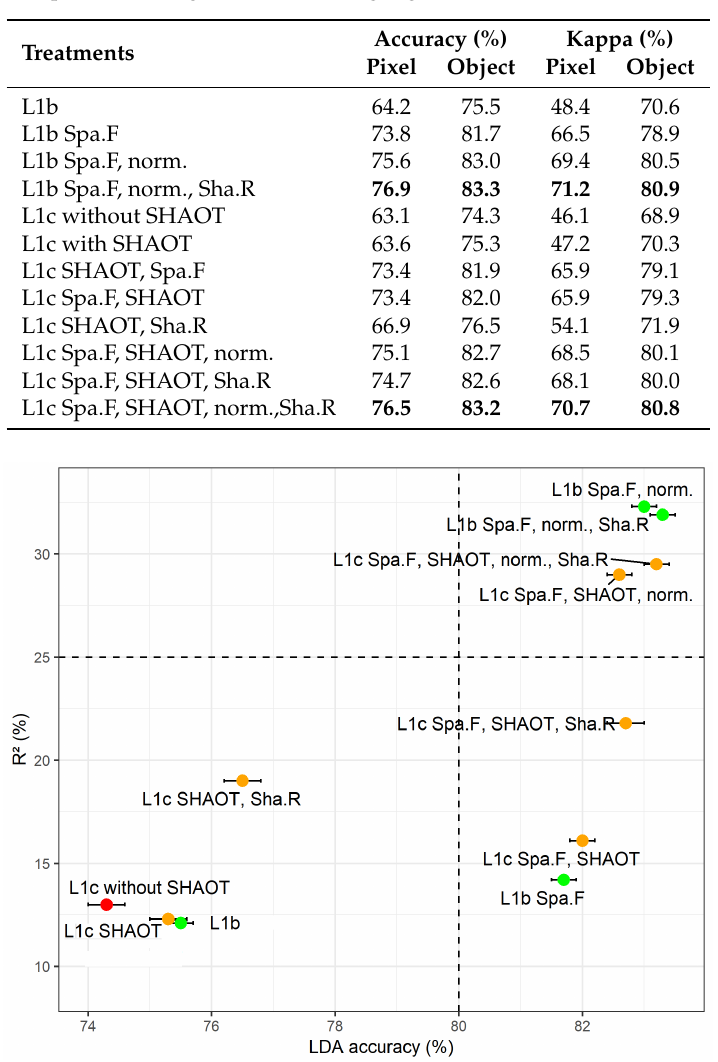
Figure 4. Treatments performance ranking by the mean R 2 (%) from the analysis of variance and LDA (%) accuracy of the object based on spectrum. Error bars represent ± standard error of the mean of 20 replicate runs. The legends and the colors refer to Figure